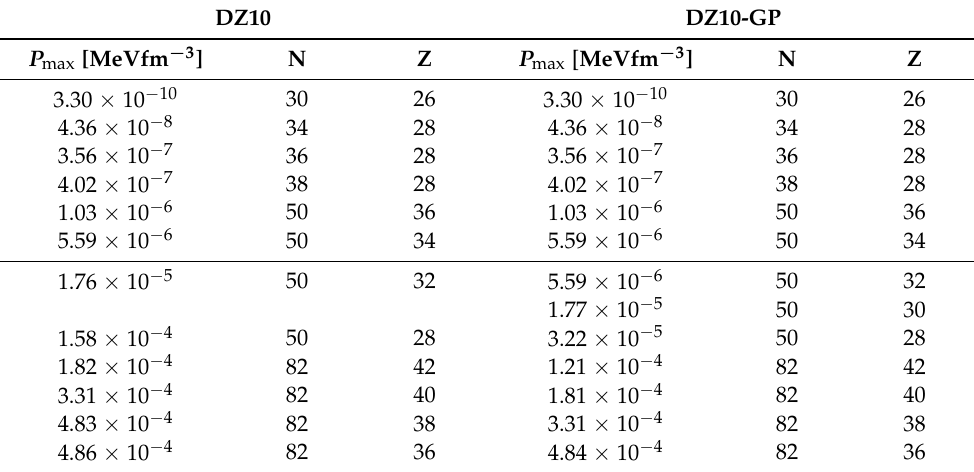
Table 2. Composition of the outer crust of a NS using the DZ10 and DZ10-GP mass models. In the first and fourth columns, we report the maximum value of pressure at which the nucleus is found using the minimisation procedure. The horizontal line separates the measured and extrapolated masses reported in AME2016